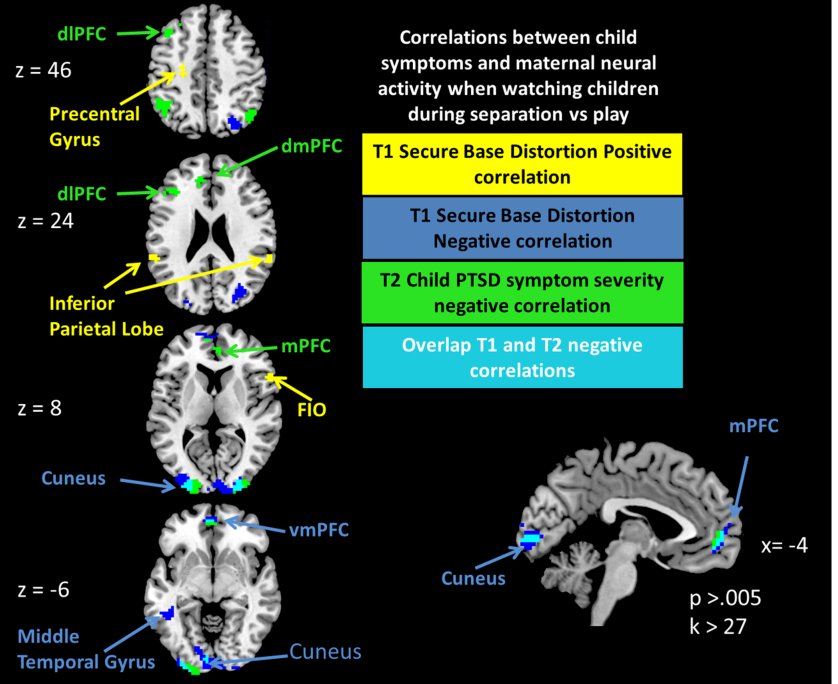
Fig 2. Correlation between child symptoms and maternal neural activity when watching children during separation vs. play. Abbreviations: mPFC = medial Prefrontal Cortex, dmPFC = dorsomedial Prefrontal Cortex, dlPFC = dorsolateralPrefrontal Cortex, vmPFC = ventromedial Prefrontal Cortex, FIO = Frontal Inferior Operculum.